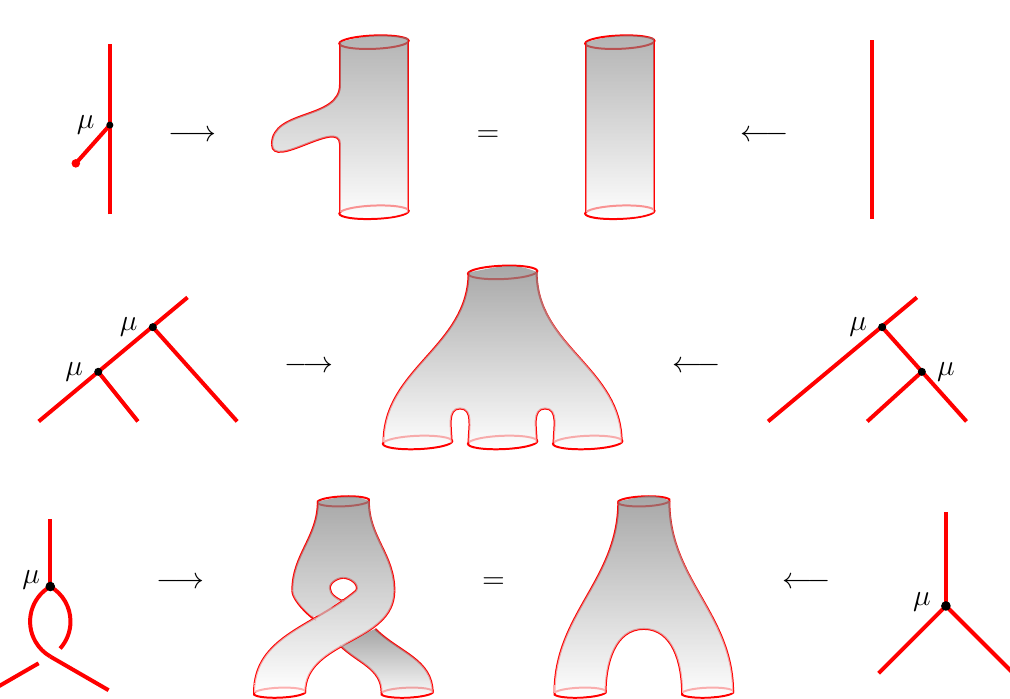
Figure 4: Replacing the anyons with empty tubes makes it clear that fusion and A braiding are trivial. This gives a geometric interpretation of the defining axioms of a Lagrangian algebra A